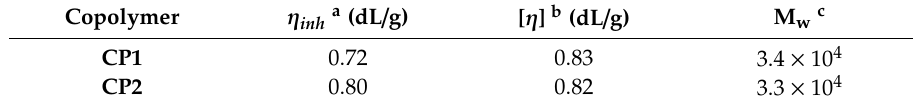
Table 1. Inherent viscosity, intrinsic viscosity, and molecular mass of polymers CP1 and CP2 . Copolymer η inh a (dL /